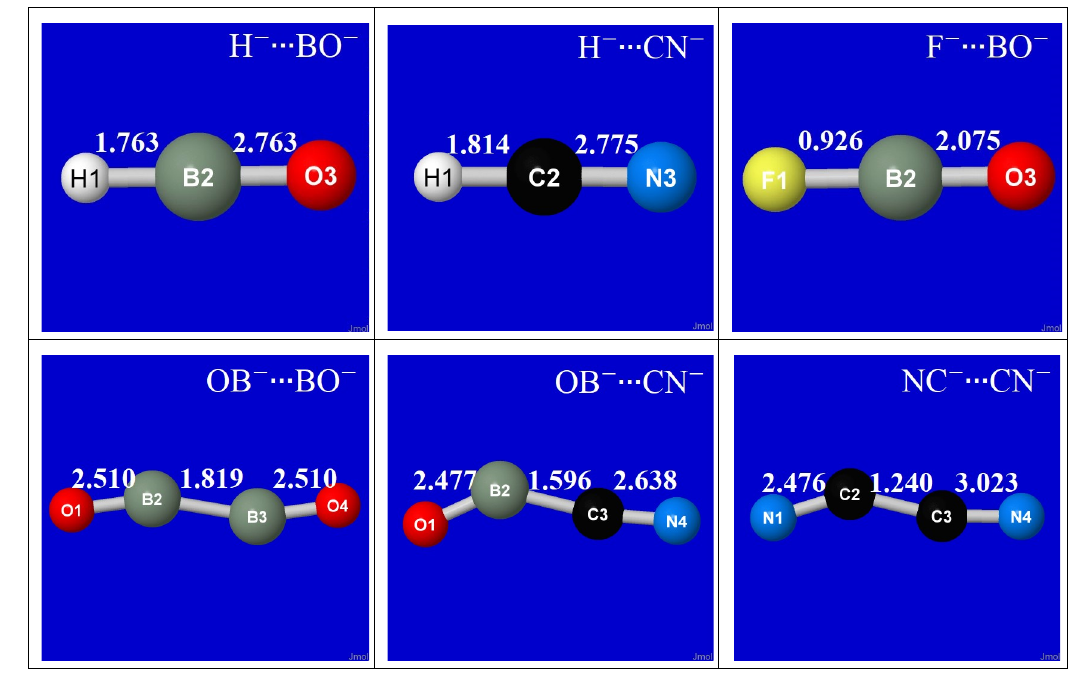
Figure 5. NRT bond orders for equilibrium species of Figure 1, showing robust single-molecule values (all b ij > ½) for each species.